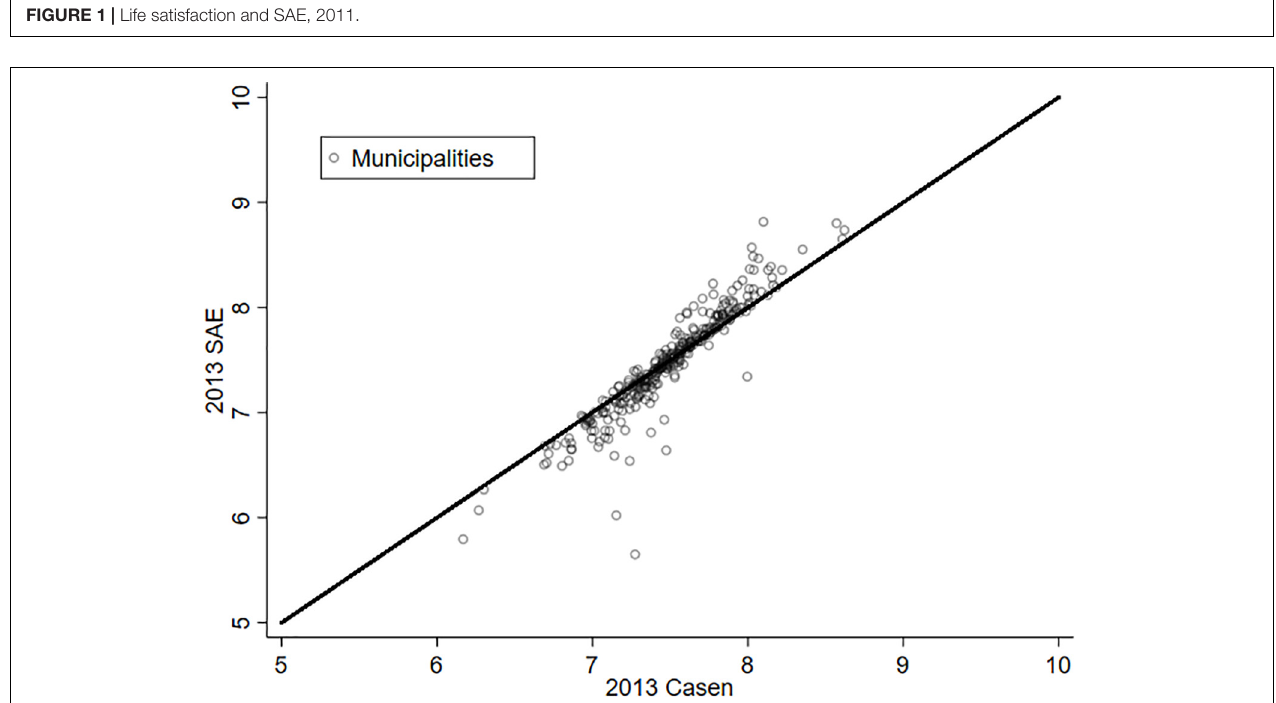
FIGURE 2 | Life satisfaction and SAE,